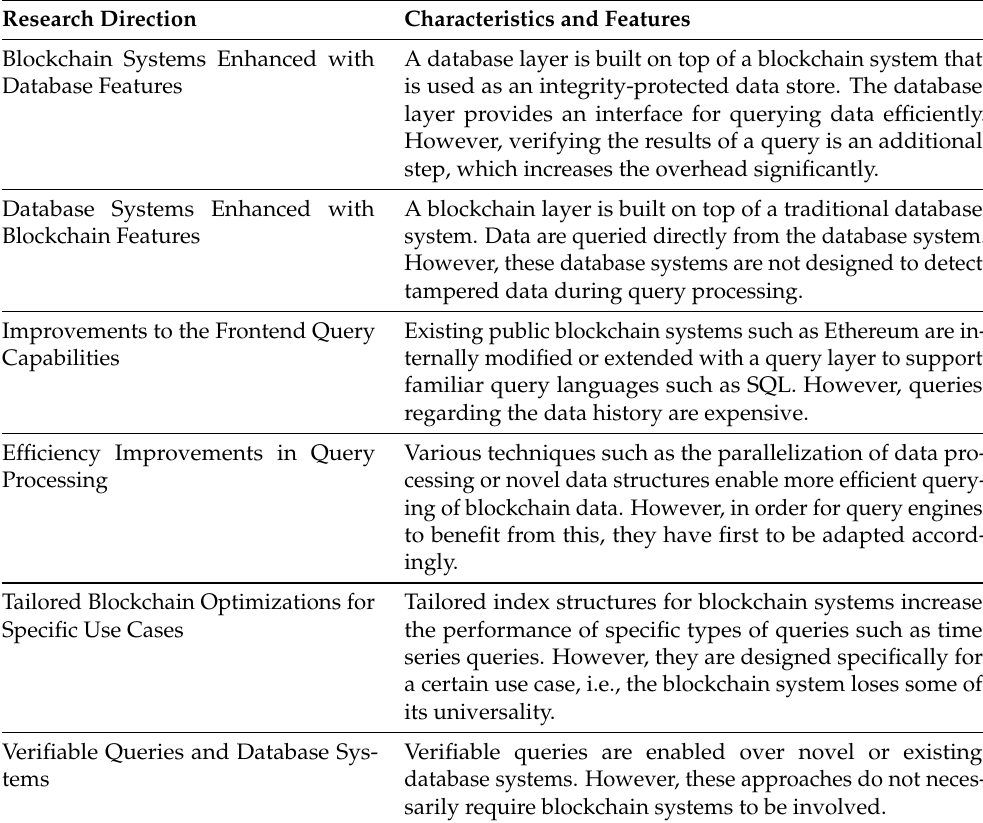
Table 5. Summary of key findings regarding the state of the